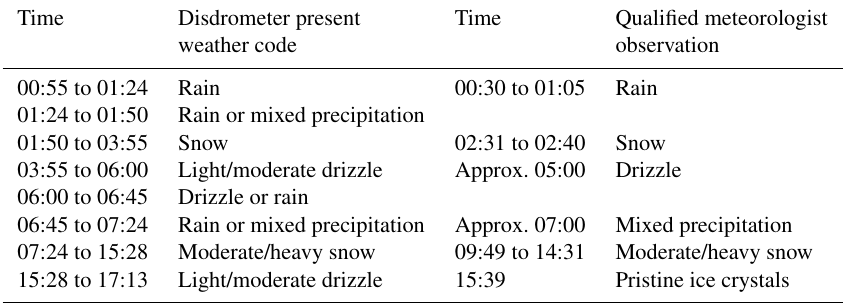
Table 4. Present weather code evolution throughout the named winter storm Doris event on 23 February 2017. All times in UTC.